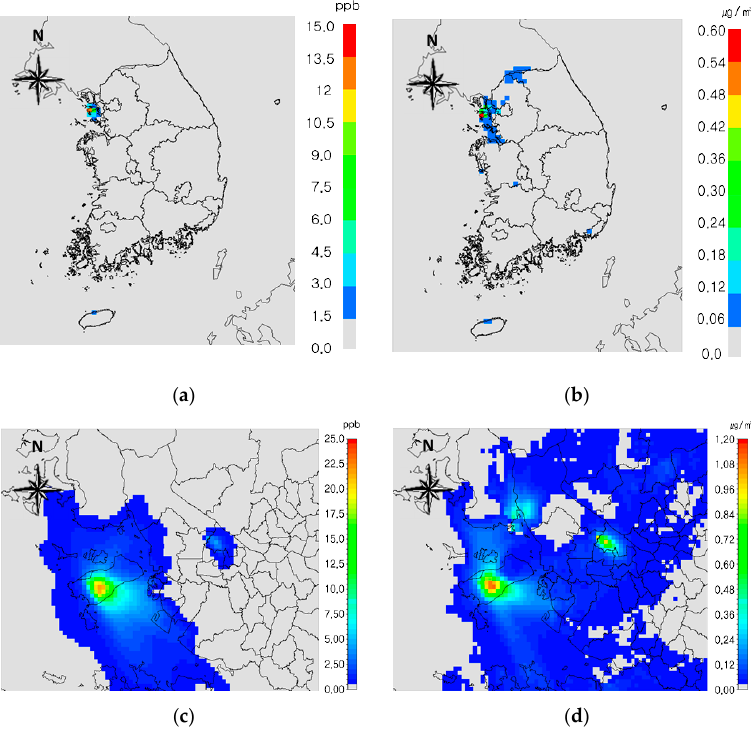
Figure 3. Impact of aviation on NO 2 for nationwide domain ( a ) and airport area domain ( c ). Impact of aviation on PM 2.5 for nationwide domain ( b ) and airport area domain ( d ).